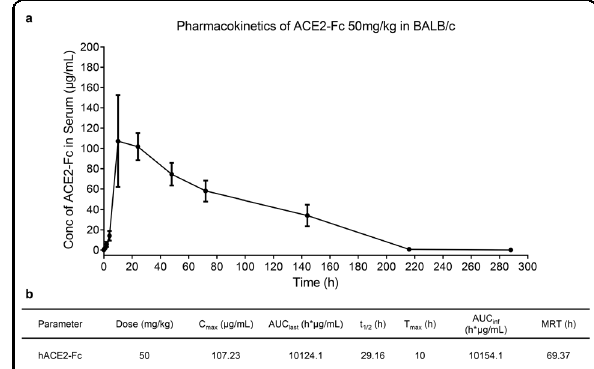
Fig. 6 hACE2-Fc had prolonged half-life in vivo. a Serum samples were collected from mice ( n = 12) at 0 min, 15 min, 1 h, 2 h, 4 h, 10 h, 24 h, 2 d, 3 d, 6 d, 9 d, 12 d, 16 d, and 22 d post administration (50 mg/ kg). Concentration of hACE2-Fc in serum was determined by ELISA and analyzed by a standard curve. Date points are mean ± SD of six biological replicates. b Pharmacokinetic parameters of hACE2-Fc were obtained by WinNonlin 8.1 noncompartment model. AUC last area under the curve, C max maximum plasma concentration, T max time to reach maximum plasma concentration, t 1/2 terminal half-life, AUC inf AUC from time zero to in fi nity, MRT mean residence